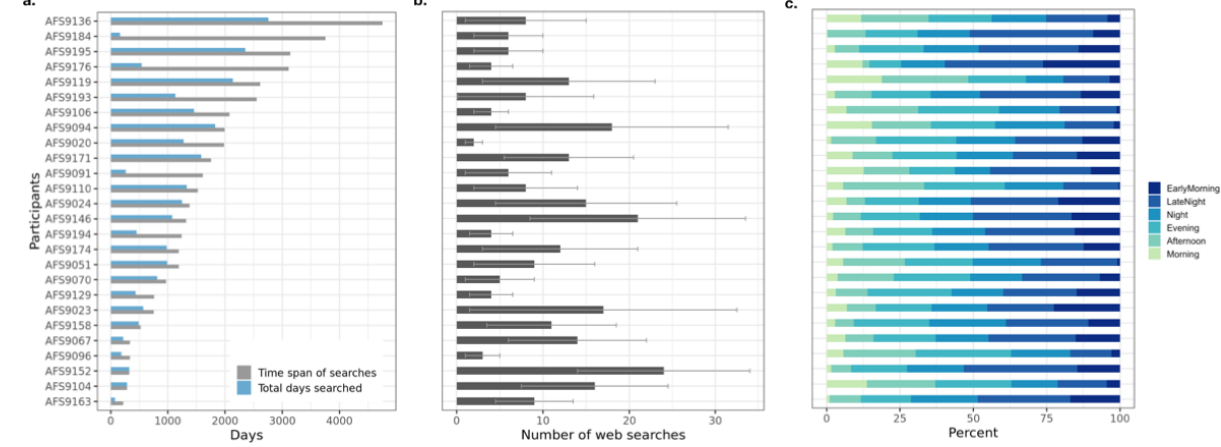
Table 2. Cue term sets developed to represent selected warning signs and a subset of top search queries that map to each of the warning signs.